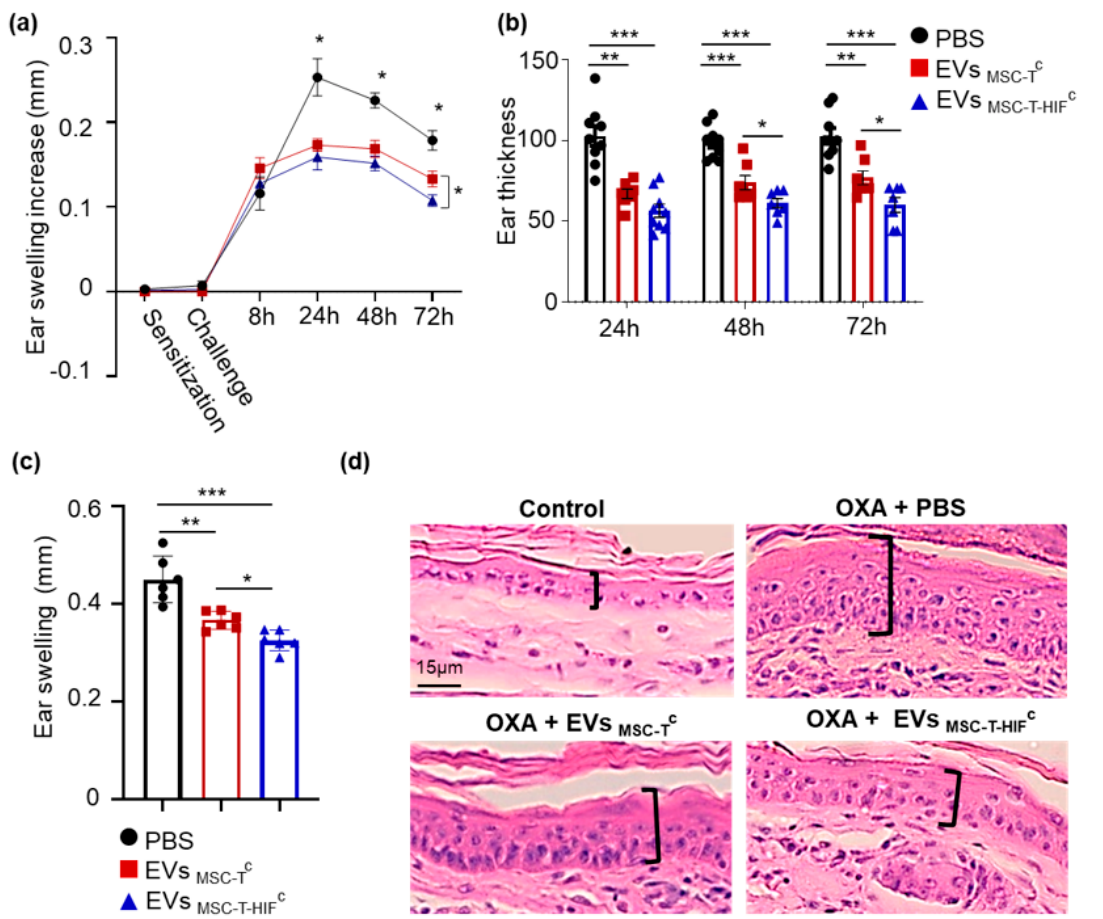
Figure 5. EV MSC-T-HIFc show immunoregulatory potential in a delayed-type hypersensitivity mouse model. BALB/c mice were sensitized by applying a 3% oxazolone solution on the abdominal skin at day − 5 and the left ear was challenged with 1% oxazolone solution at day 0. Mice were injected with the following different treatments: PBS (black circle), EV MSC-Tc (red triangle) or EV MSC-T-HIFc (blue square) 6 h after challenge. The non-challenged right ear was used as a no-inflammation control. ( a ) Ear swelling was recorded as an increase in thickness (in mm) at different time points. Data are presented as the mean ± SEM of seven mice in each group. Tukey’s multiple comparisons test was used for statistics. ( b ) Ear thickness measured at different time points. Data reflect the reduction in thickness caused by each treatment relative to the PBS control ear. Graph represents mean ± SD of seven mice in each group. Tukey’s multiple comparisons test was used for statistics. ( c ) Ear swelling measurement on histological sections. Bars represent the mean ± SD of thickness of six animals. Paired t -test was used for statistics. * p < 0.05, ** p < 0.01, *** p < 0.001. ( d ) Representative histological hematoxylin and eosin-stained sections of ears at the 72 h time point. Epithelial enlargement is noted in brackets. Scale bar: 15 μ m.